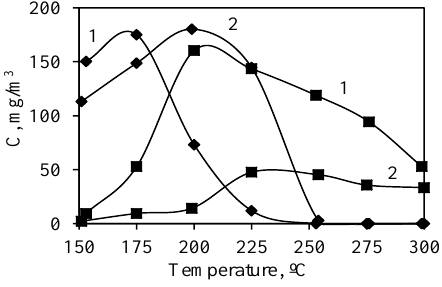
Figure 9. Changes in the concentrations of pentanal ( ♦ ) and CO ( ■ ) formed during propanol catalytic oxidation in synthetic (1) and calcined (2) samples.